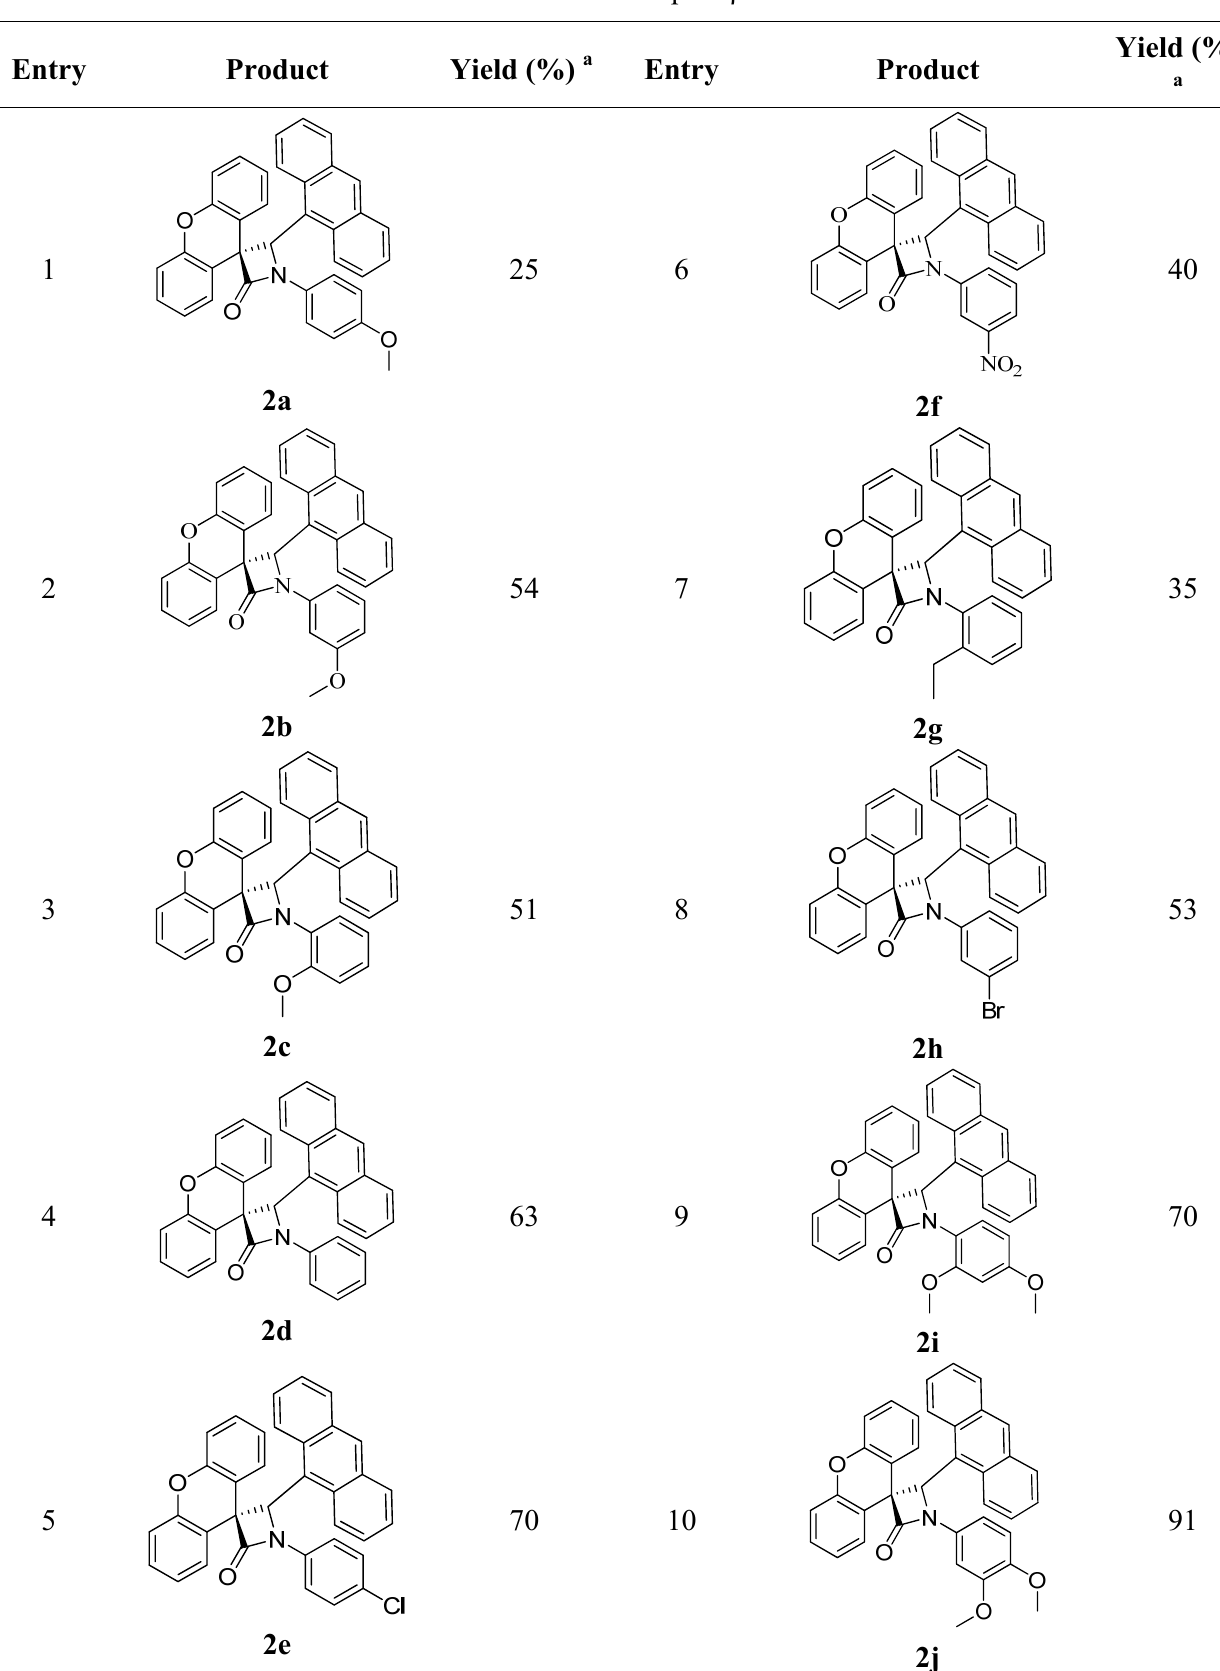
Table 1. Structures of spiro- β